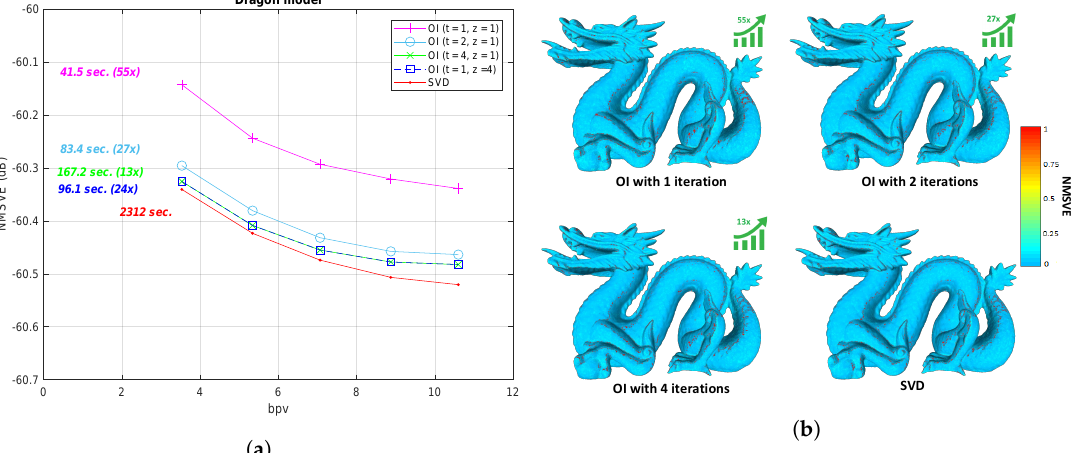
Figure 15. ( a ) NMSVE vs bpv plot of the Dragon model (437,645 vertices); ( b ) normal difference with bpv 7.06. The arrow represents the speed-up in execution time compared to